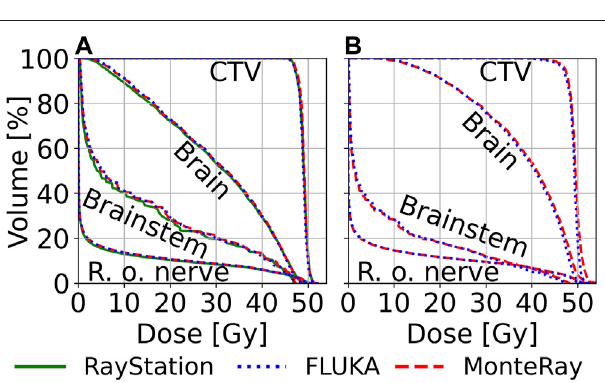
FIGURE 7 | Computed DVHs for the CTV, the brain, the brainstem and the right optical nerve (r. o. nerve) are shown. DVHs were computed for RayStation (green, solid line), FLUKA (blue, dotted line) and MonteRay (red, dashed line). In panel (A) , DVHs for the patient case without a magnetic fi eld areshown whileinpanel (B) DVHscalculatedfor thecase with anapplied magnetic fi eld are shown.